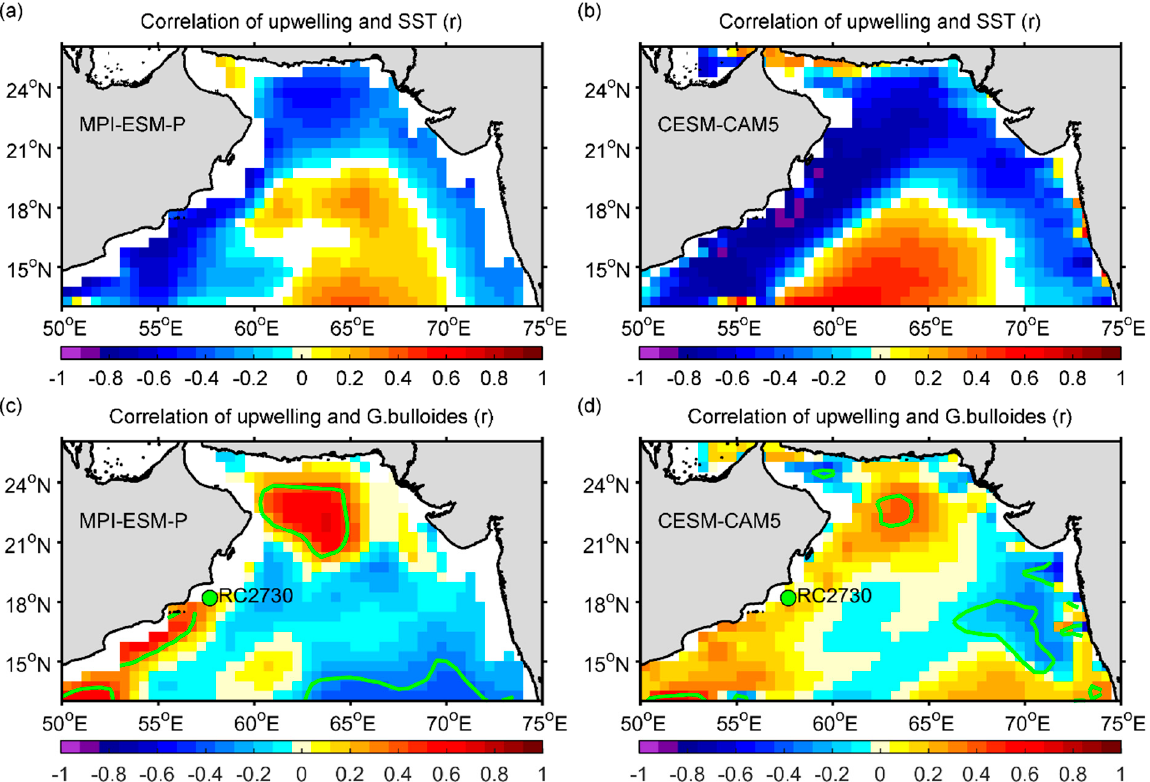
Figure 2. Correlation coefficient between the SST and the upwelling velocity modeled by ( a ) MPI-ESM-P and ( b ) CESM- CAM5 with significance level greater than 95% ( p -value < 0.05). Correlation coefficient between the G. bulloides abundance and the upwelling velocity simulated by ( c ) MPI-ESM-P and ( d ) CESM-CAM5. The green point marks the location of the sediment core where the G. bulloides abundance is recorded. The regions surrounded by the green contour lines present significant correlations that are at a higher level than 90% ( p -value < 0.1). All the correlation coefficients are calculated from the detrended time series.